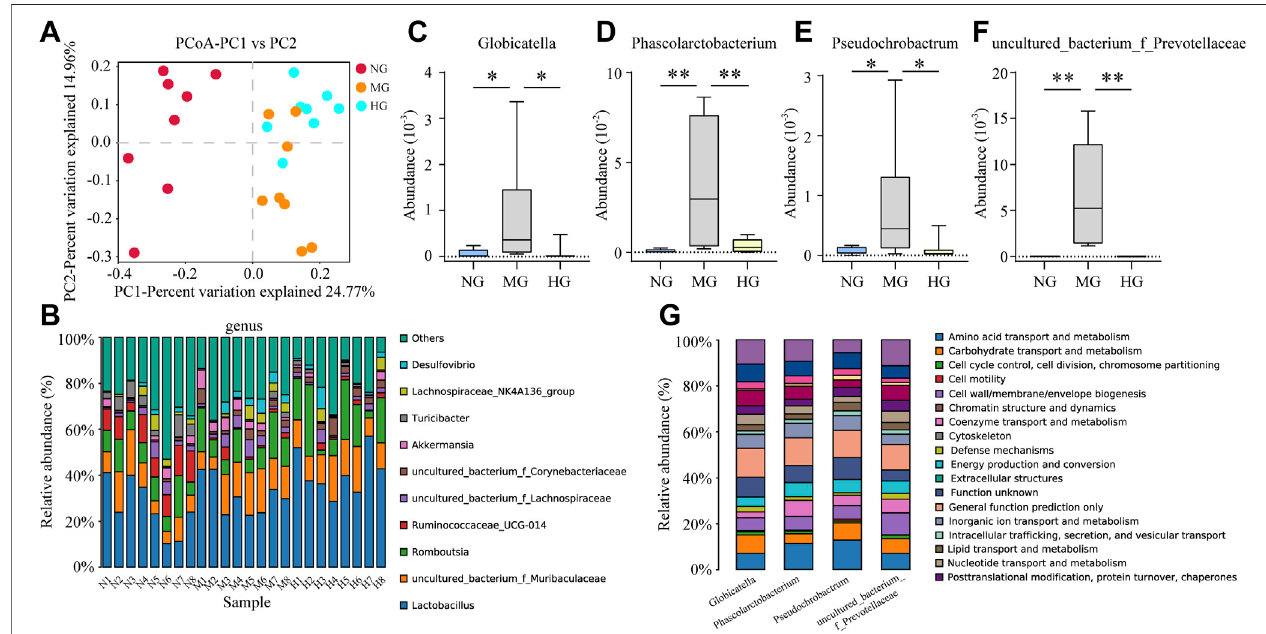
FIGURE5| GutmicrobiotaanalysisofNG,MG,andHG (A) PCoAscoreplots; (B) gutmicrobiota compositionpro fi leatgenuslevel;abundanceofGlobicatella (C) , Phascolarctobacterium (D) , Pseudochrobactrum (E) , and uncultured_bacterium_f_Prevotellaceae (F) , ** p < 0.01, * p < 0.05; (G) biological function prediction of Globicatella, Phascolarctobacterium, Pseudochrobactrum, and uncultured_bacterium_f_Prevotellaceae.